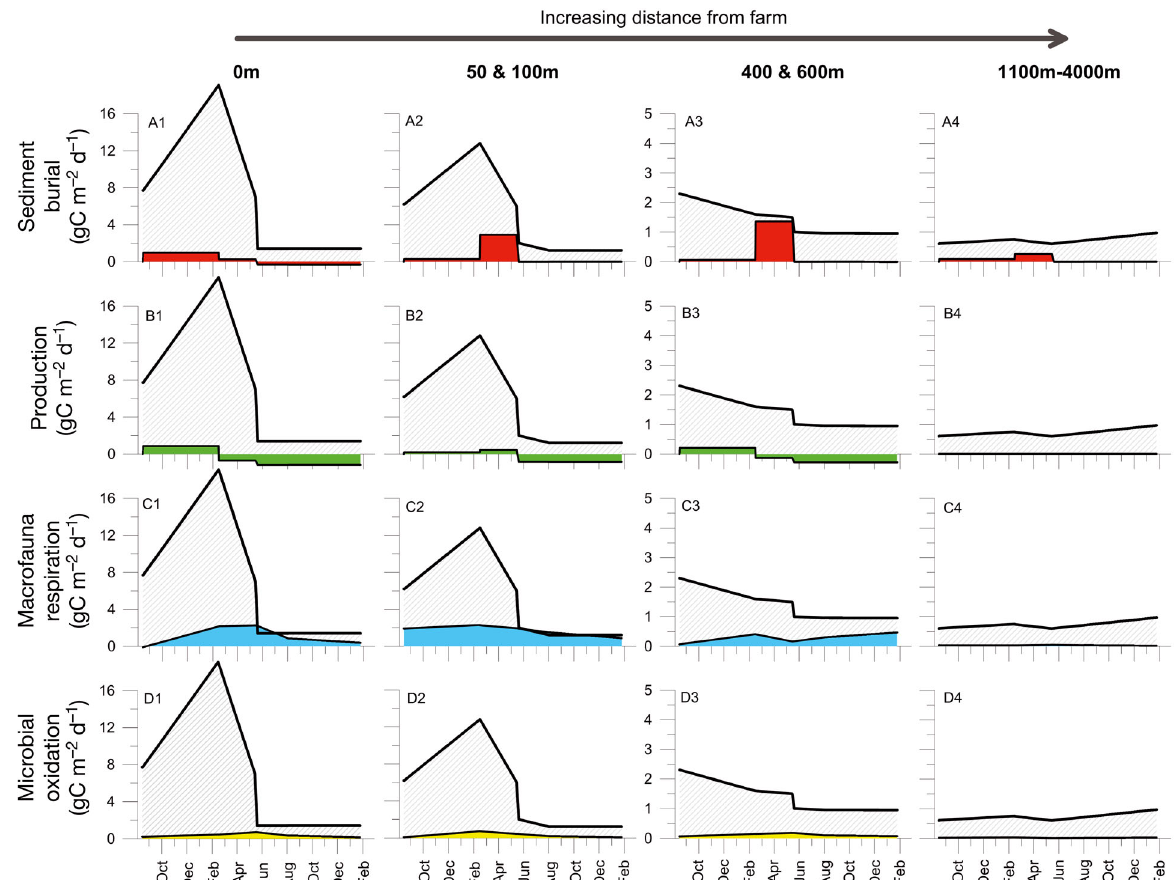
Fig. 8. Carbon utilization in relation to influx for compartments: sediment burial (red area), fauna production/somatic growth (green), macrofaunal respiration (blue) and total microbial oxidation (yellow) and 4 distances along the main transect: 0 m sta- tions (A1−D1; stations 0m-A and 0m-B averaged), 50 and 100 m stations (A2−D2; averaged), 400 and 600 m stations (A3−D3; averaged), 1100−4000 m stations (A4−D4; averaged). Solid black line and hatched area on each plot indicate depositional flux (gC m −2 d −1 ). Note the y -axis scale change between 0 and 50−100 m and the more distant stations (400−600 and 1100−4000